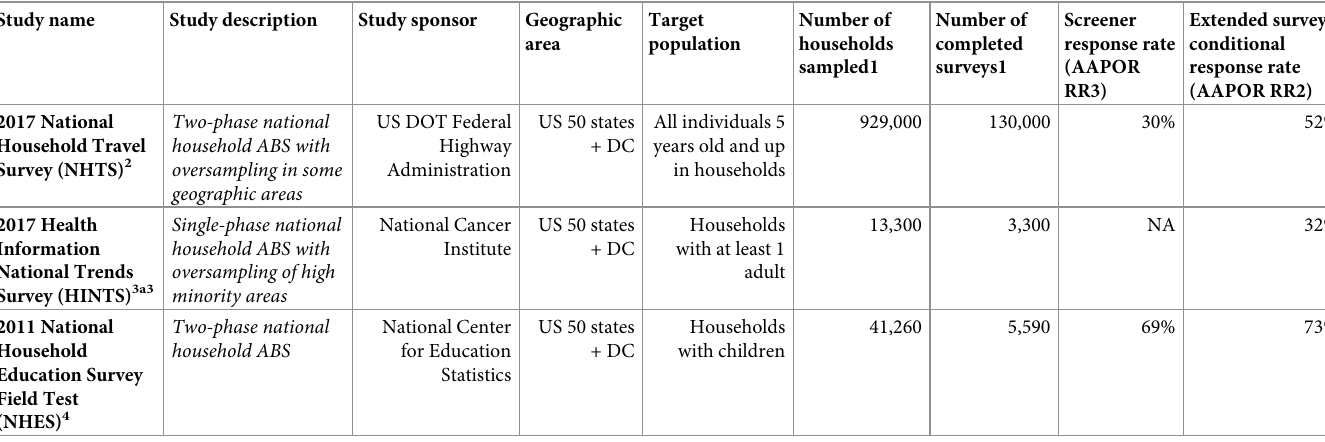
Table 1. Household studies used for analyses.